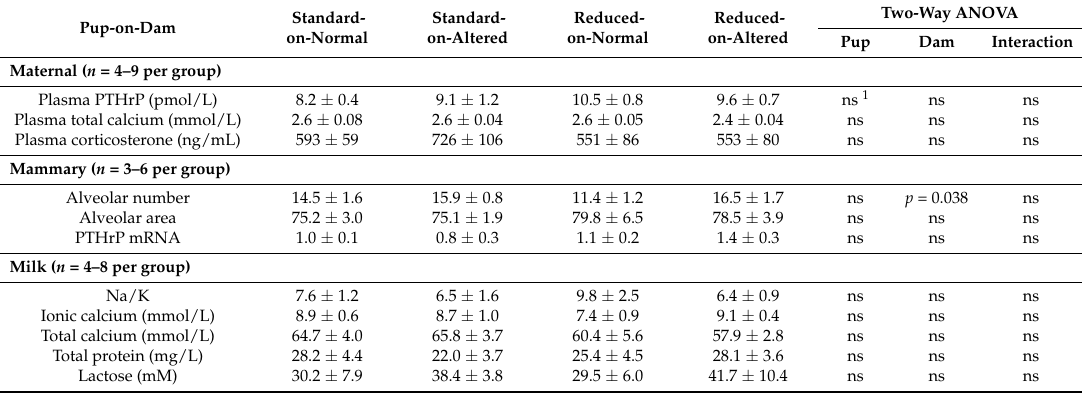
Table 2. Maternal plasma, mammary and pooled milk composition in the four cross-foster groups on postnatal day 6. Pup-on-Dam